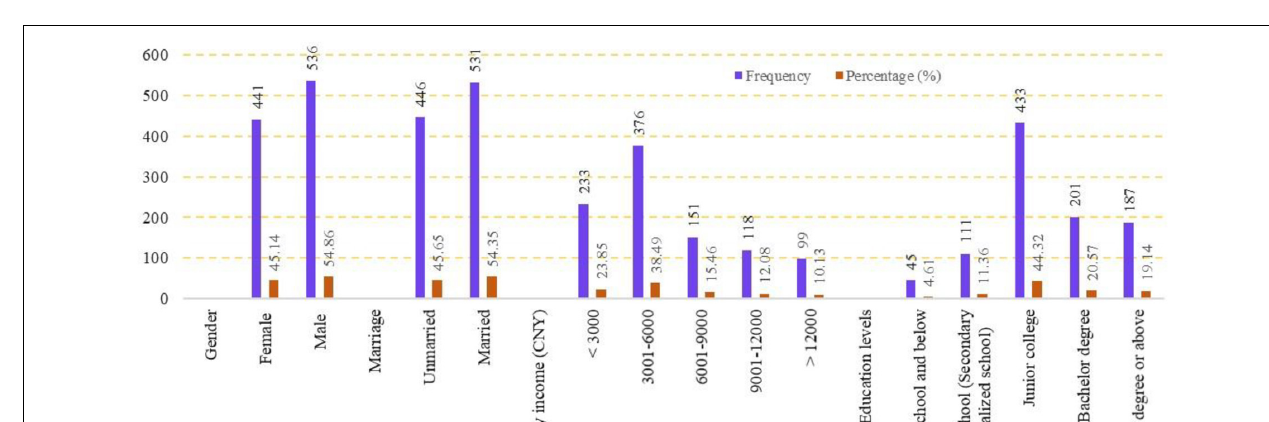
FIGURE 1 | Research model.